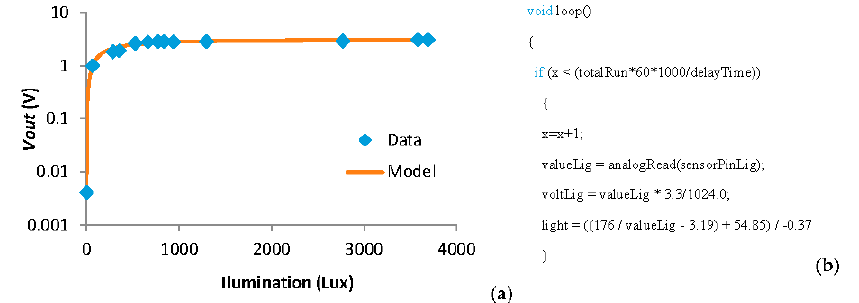
Figure 13. ( a ) Data and ( b ) code of the light sensor.